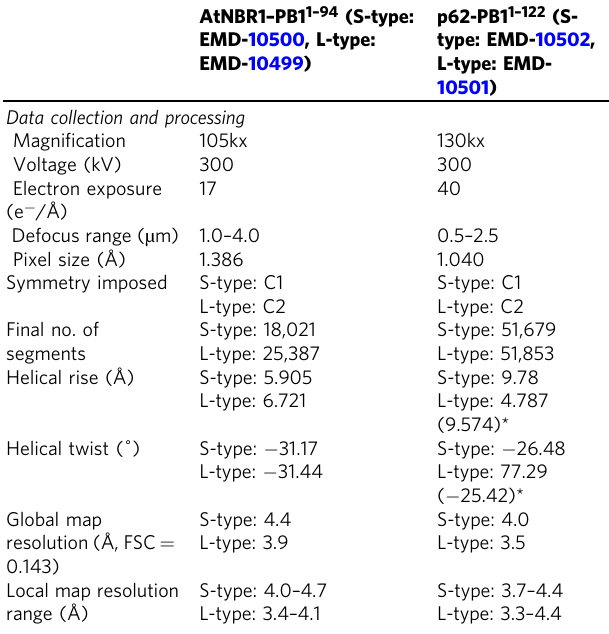
Table 1 Cryo-EM data collection and helical